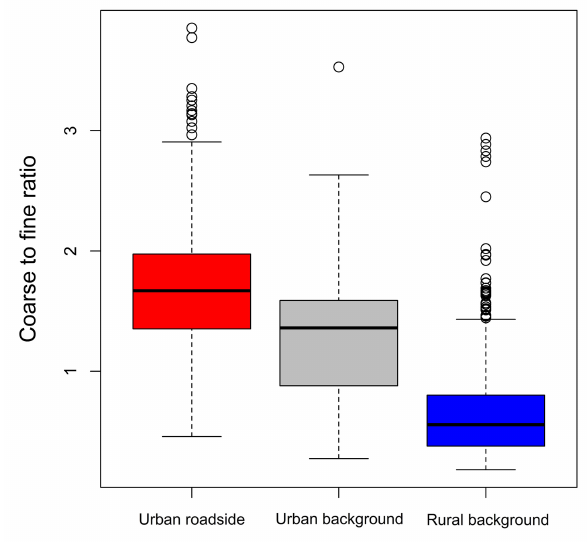
Figure 7. Ratio of the coarse (PM 10 –PM 2 . 5 ) to fine (PM 2 . 5 ) frac- tion of